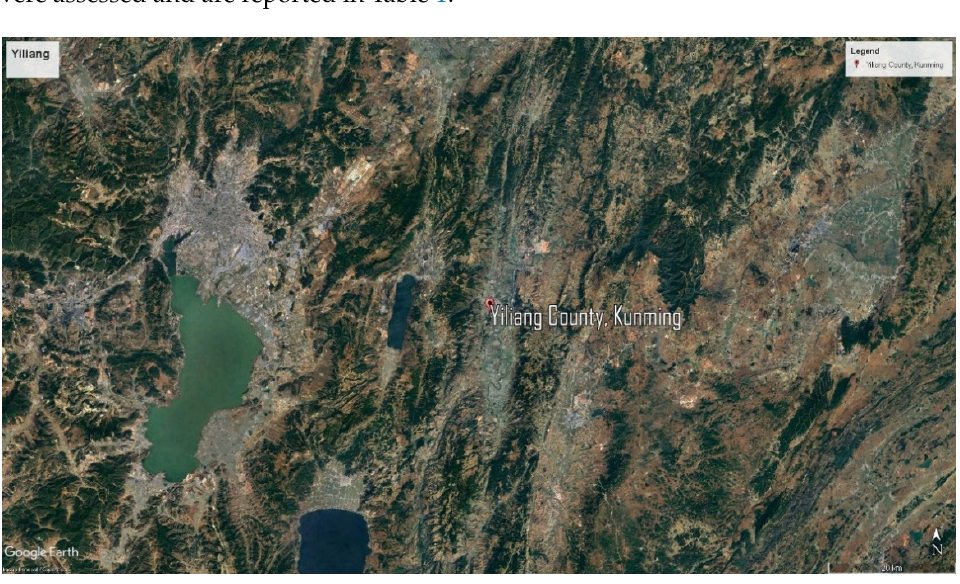
Figure 1. Location map of the study